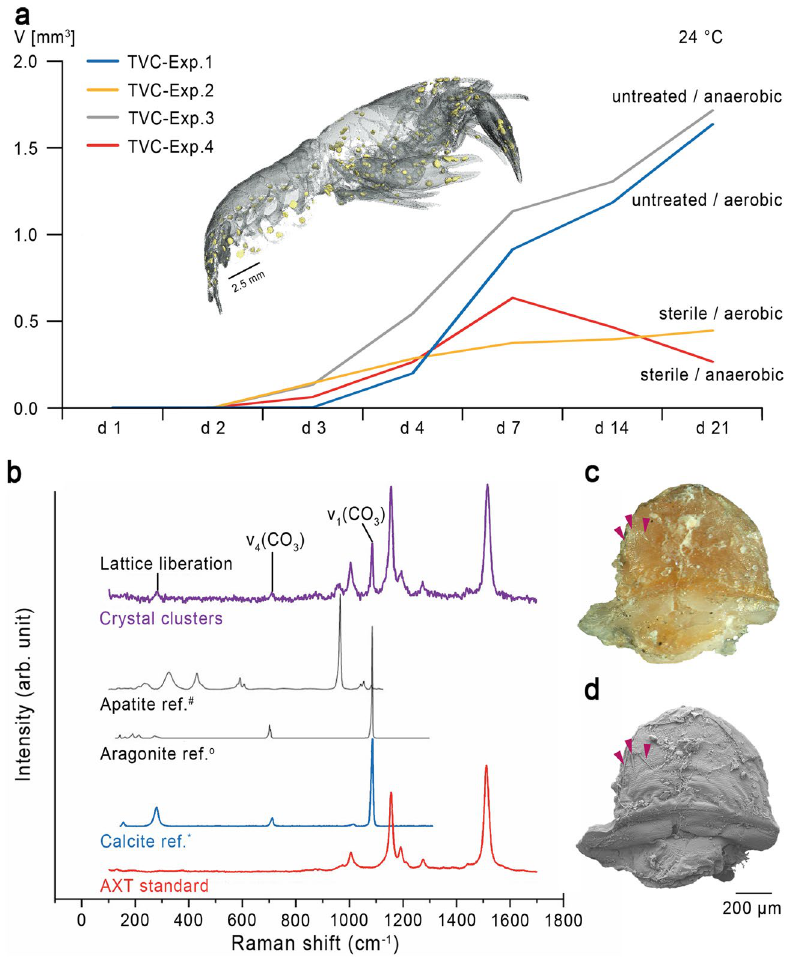
Figure 3. Calcite precipitation inside decomposing crayfish. ( a ) Median value of the increase in the total volume of calcite of Exp. 1–4 for a duration of 21 days at a constant temperature of 24 °C, including a translucent 3D-model of an individual showing reconstructed 3D-models of calcite clusters at the inner side of the cuticle (Yellow structures). ( b ) Representative Raman spectra of observed crystal clusters compared to Raman reference spectra of crystalline apatite, aragonite and calcite, taken from the RRUFF Raman data base (#R060070, 0R060070, *R040170 42 ). Raman spectra of the crystal clusters exhibit main Raman bands typically for crystallized calcite and the β-carotene, astaxanthin. ( c ) Optical image of a semi-circular calcite cluster with three mineralized setae (pink arrows). ( d ) SEM image of the calcite cluster shown in ( c